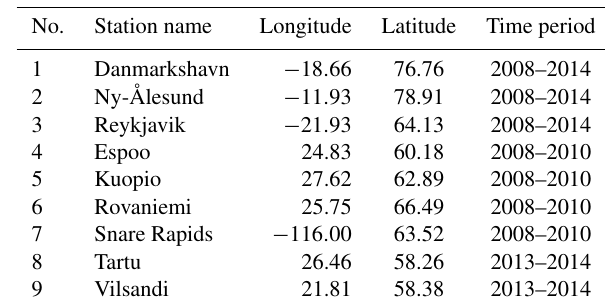
Table 1. List of GNIP stations used in this